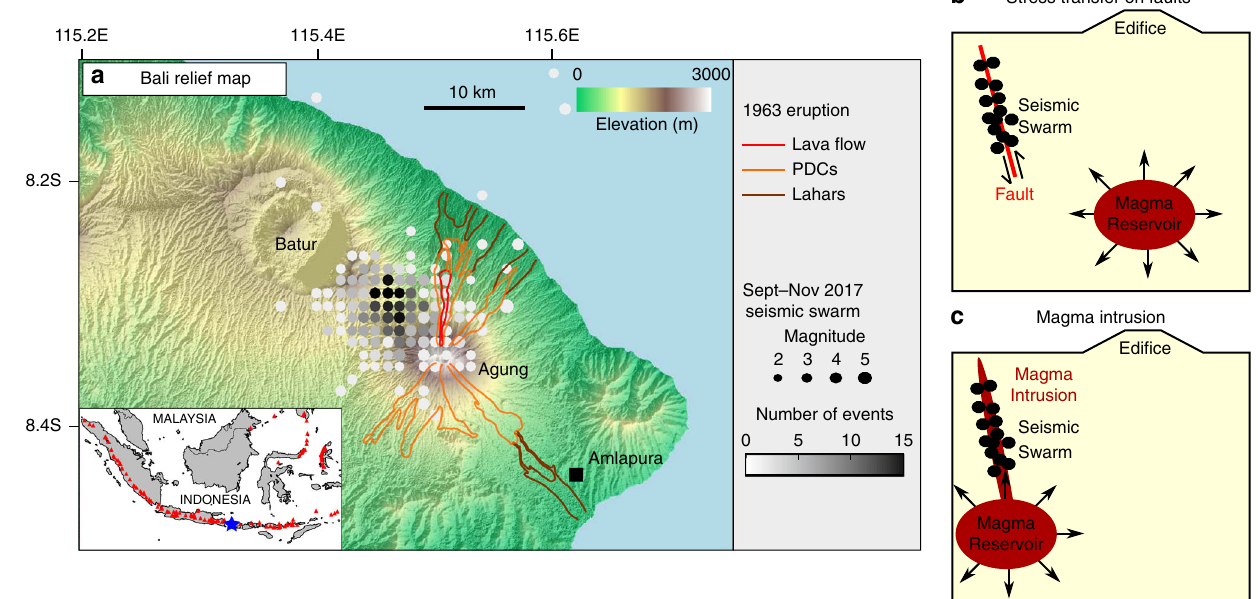
Fig. 1 Location of the September − November 2017 seismic swarm recorded at Agung volcano prior to the eruption. a Topographic map of Bali island showing the volcanoes Agung and Batur, the density of seismic events (Meteorological, Climatological, and Geophysical Agency, BMKG) and the extent of the 1963 eruptive products 19 . Inset shows the location of the studied area (blue star) along the Indonesian volcanic arc. The spatial offset between the seismicity and the edi fi ce can be explained by b stress transfer on existing faults from a central magmatic system or c stress changes associated